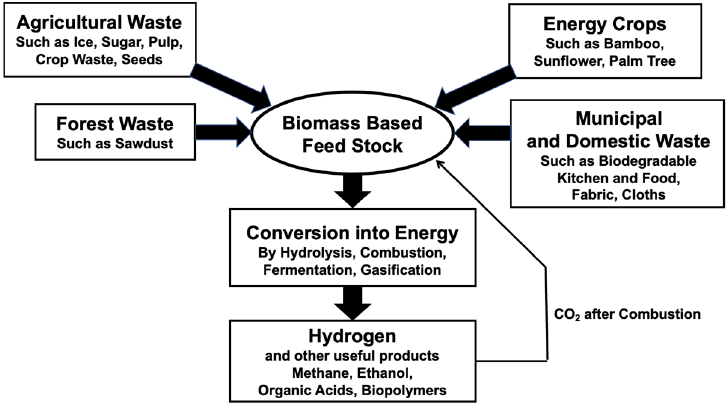
Figure 7. Various biomass sources and their conversion into H 2 and other useful products. Reprinted with permission from [135].